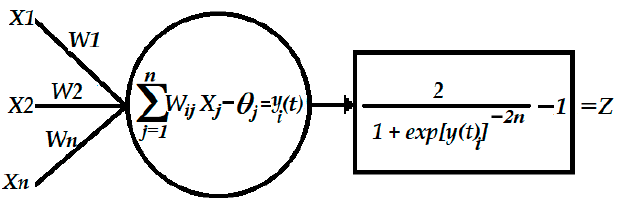
Figure 4. Representation of an artificial neuron called a perceptron.